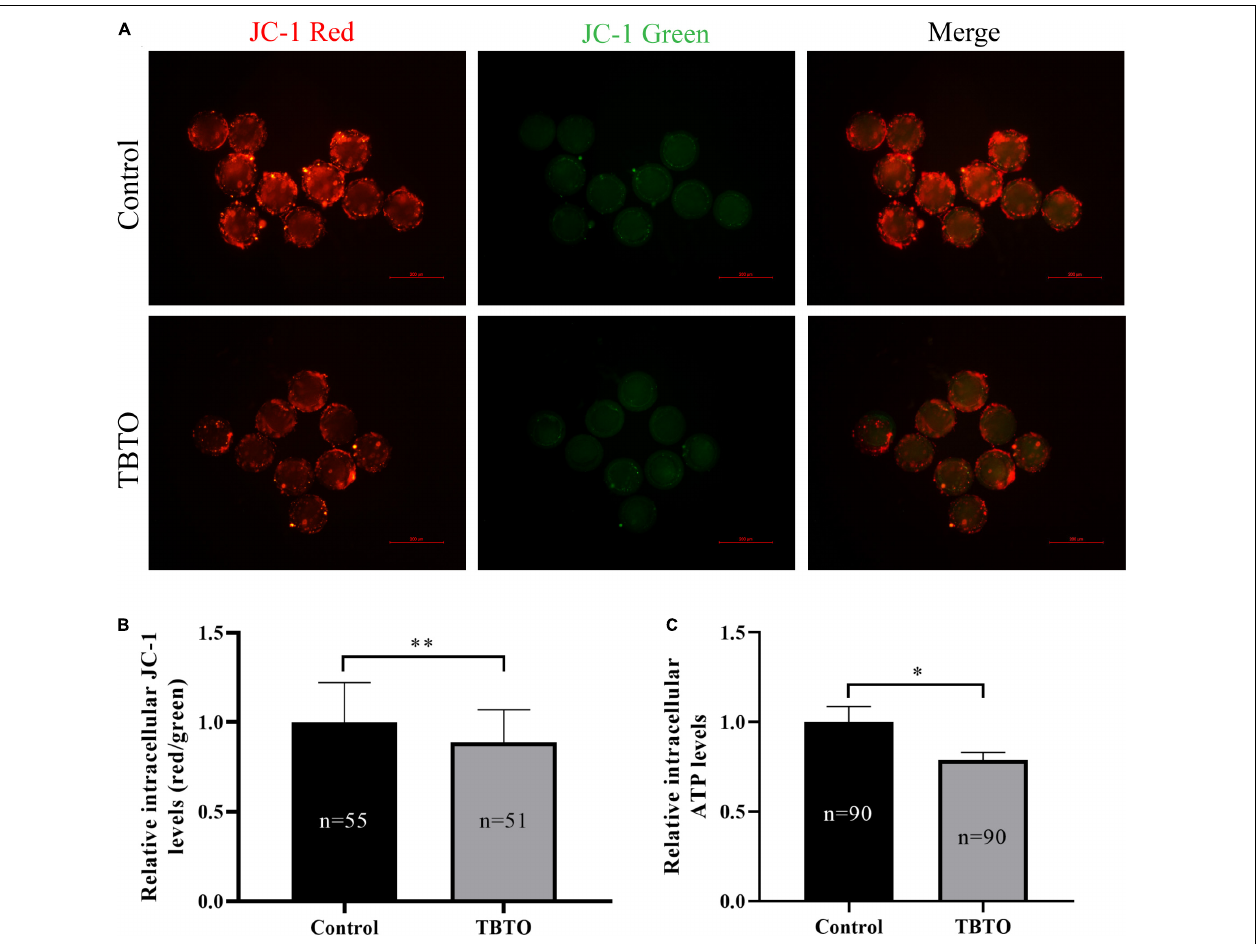
FIGURE 5 | Effects of TBTO exposure on mitochondrial function in porcine oocytes. (A) Representative fluorescence images of JC-1-stained porcine oocytes in the control and TBTO exposure group at the end of the IVM period. Scale bar = 200 µ m. (B) Quantification of the relative JC-1 fluorescence intensity in porcine oocytes from the control and TBTO exposure group. (C) Quantification of relative intracellular ATP levels in porcine oocytes from the control and TBTO exposure group. The numbers of oocytes examined from the different groups are indicated by the bars. ∗ p < 0.05; ∗∗ p < 0.01 compared to the